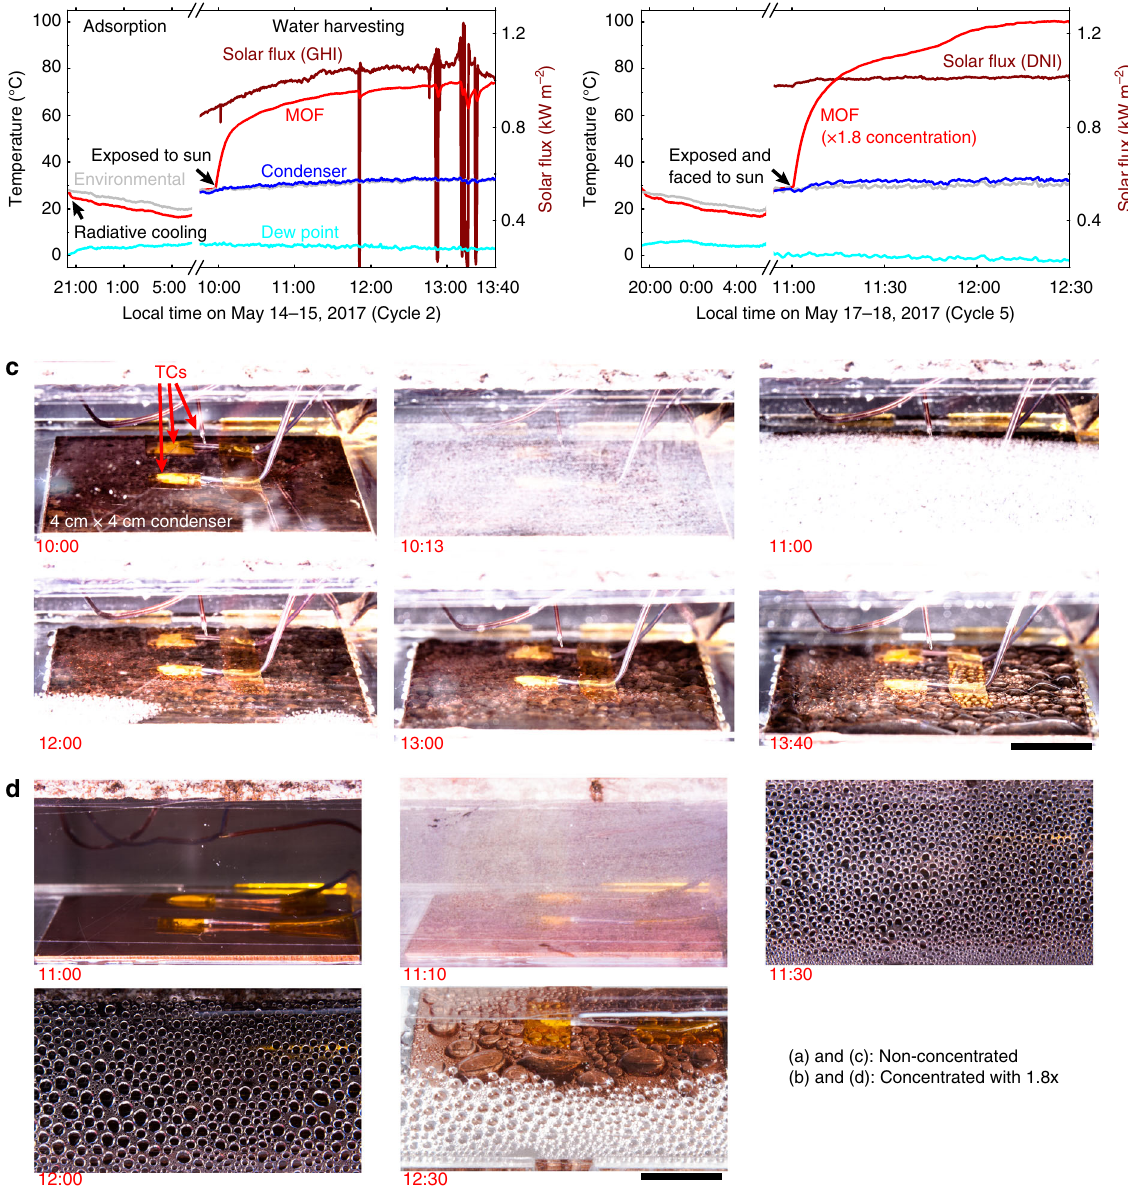
Fig. 3 Water harvesting test results. a , b Representative temperature pro fi les (environmental, MOF layer, dew point and condenser) and solar fl ux (global horizontal irradiance (GHI) or direct normal irradiance (DNI)) as a function of local time for representative non-concentrated (Cycle 2, May 14 − 15, 2017) and concentrated with 1.8× (Cycle 5, May 17 − 18, 2017) cycles, respectively. c , d Representative photos illustrating droplet condensation on the copper plate condenser (4 cm by 4 cm) during the water harvesting process as a function of local time for representative non-concentrated (cycle 2) and concentrated (cycle 5) cycles, respectively. Shortly after the solar exposure, the view port fogged up due to condensation of desorbed vapour for both cycles. Thermocouples (TCs) measuring the condenser, air gap and the MOF layer temperatures are also shown. Due to the higher solar fl ux with the concentration, the rate of temperature increase of the MOF layer was signi fi cantly faster than the non-concentrated cycle, reducing the time required for desorption. The temperature slope change at ~11:45 hours local time indicates near completion of desorption. The predicted amount of harvested water for the non-concentrated (cycle 2) and concentrated (cycle 5) cycles were ~0.12 L and ~0.28 L per kg of MOF, respectively. Scale bars are 1